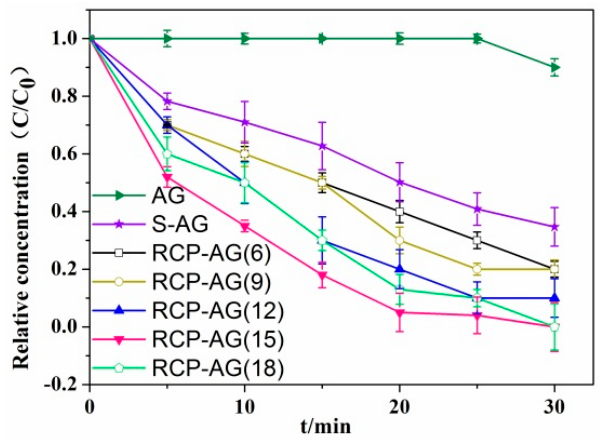
Figure 8. Photocatalytic reduction of Cr(VI) over different samples under visible light with 40 µmol/L formic acid.